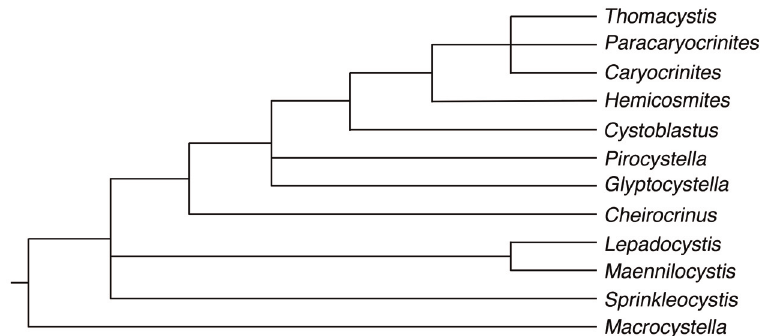
Fig. 11. Strict consensus tree derived from the eight most parsimonious trees for the genera in Table 1. The tree was rooted on Macrocystella and identifies the hemicosmitoids as the most derived group, with Cystoblastus as their immediate sister group. The glyptocystitids Glyptocystella and Pirocystella are part of a trichotomy, but both more closely related to Cystoblastus and the hemicosmitoids than Cheirocrinus . Among the hemicosmitoids, Hemicosmites is plesiomorphic and a sister group to the caryocrinitids, Caryocrinites and Paracaryocrinites , plus Thomacystis , which form a second trichotomy. Sprinkleocystis and the callocystitids, Lepadocystis and Maennilocystis form a separate lineage.